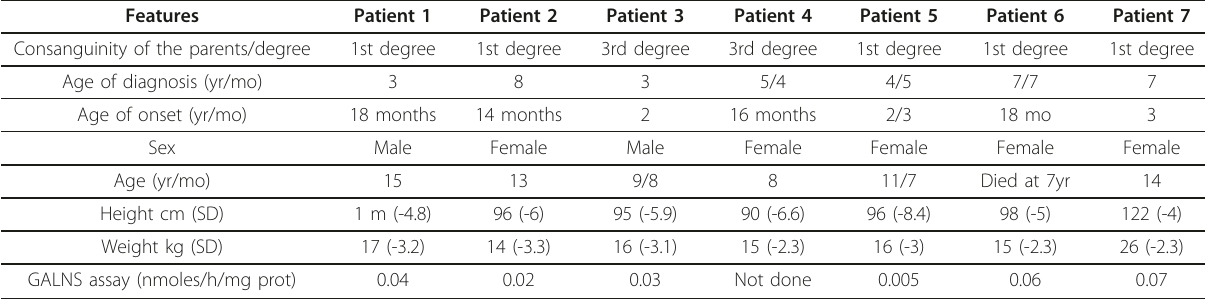
Table 1 Description of the 7 MPS IVA patientsyr: years, mo: months